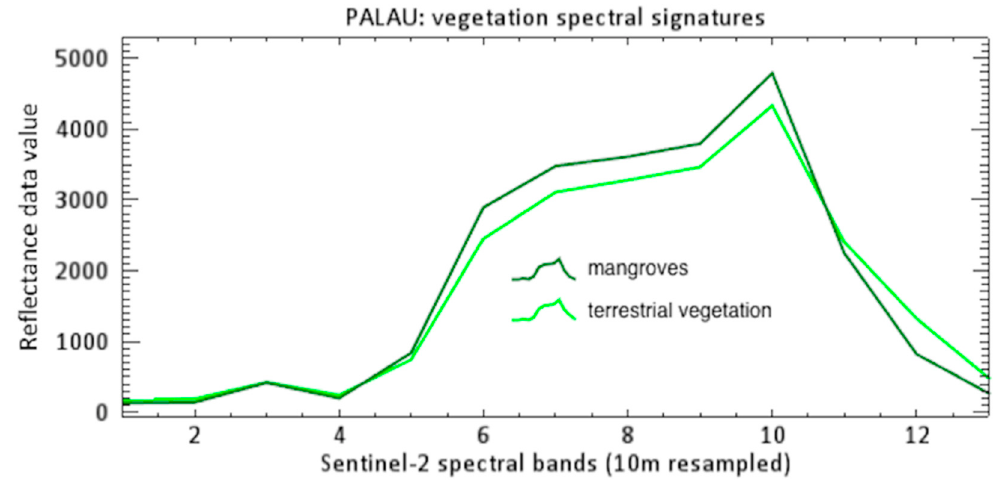
Figure 5. Spectral signatures of mangroves and terrestrial vegetation in Sentinel-2 spectral bands.